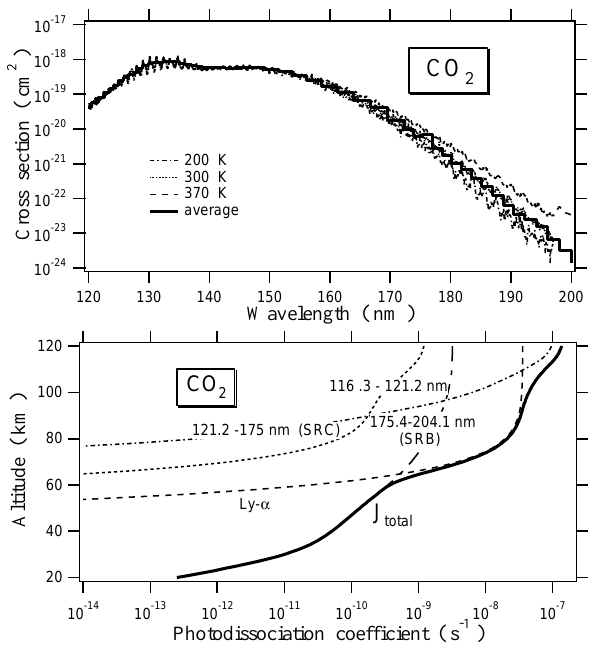
Fig. 8. Absorption cross section and photodissociation coefficient for CO 2